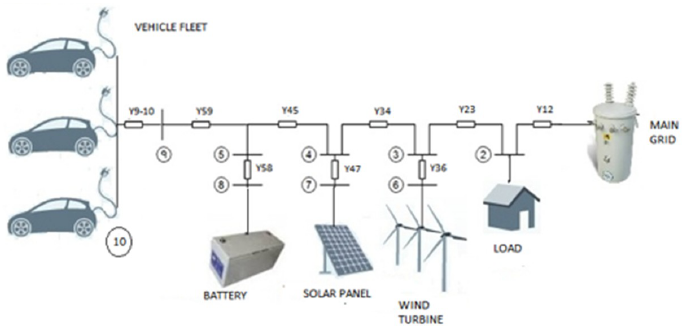
Figure 7. Microgrid test scheme.